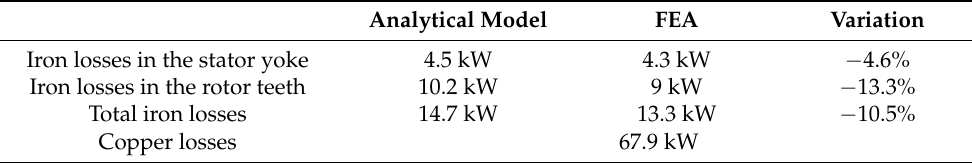
Table 5. Losses of the optimal generator at the maximal power (2 MW).